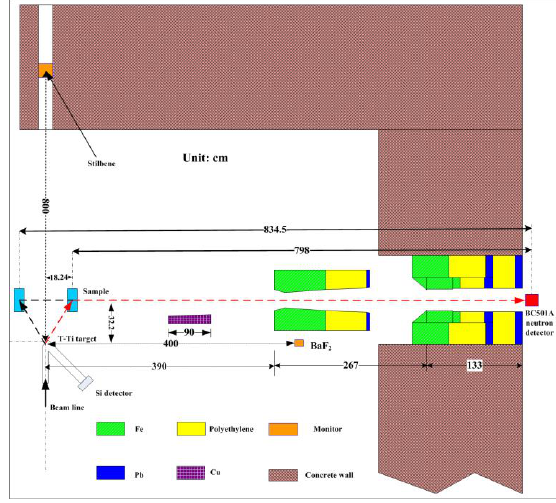
Fig. 1. Experimental arrangement for measuring the neutron leakage spectra from iron slabs.(The red dotted lines indicate the typical neutron